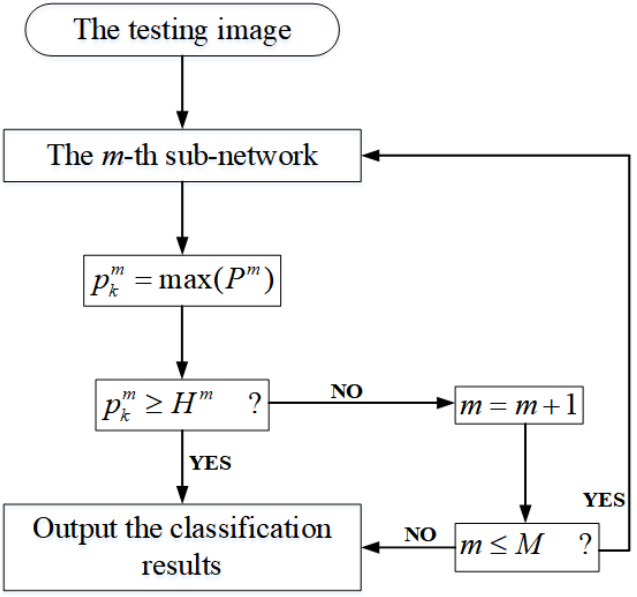
Figure 3. Progressive image classification by HCNNs in the test